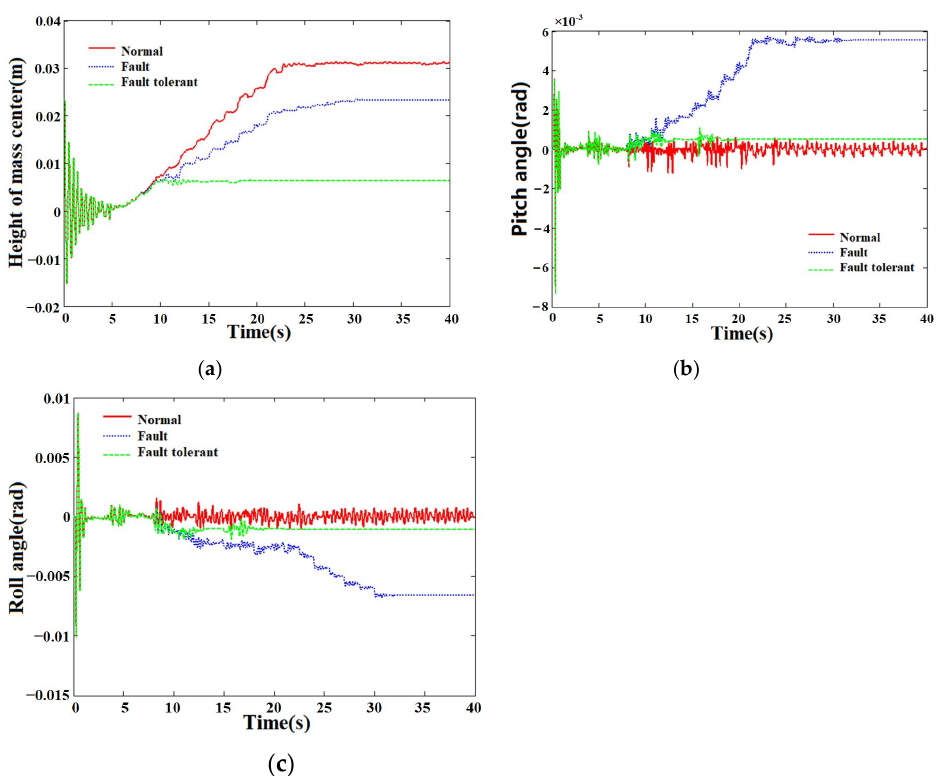
Figure 13. Performance comparison before and after fault tolerant control under Fault 1: ( a ) Relative height of mass center; ( b ) Pitch angle; ( c ) Roll angle.